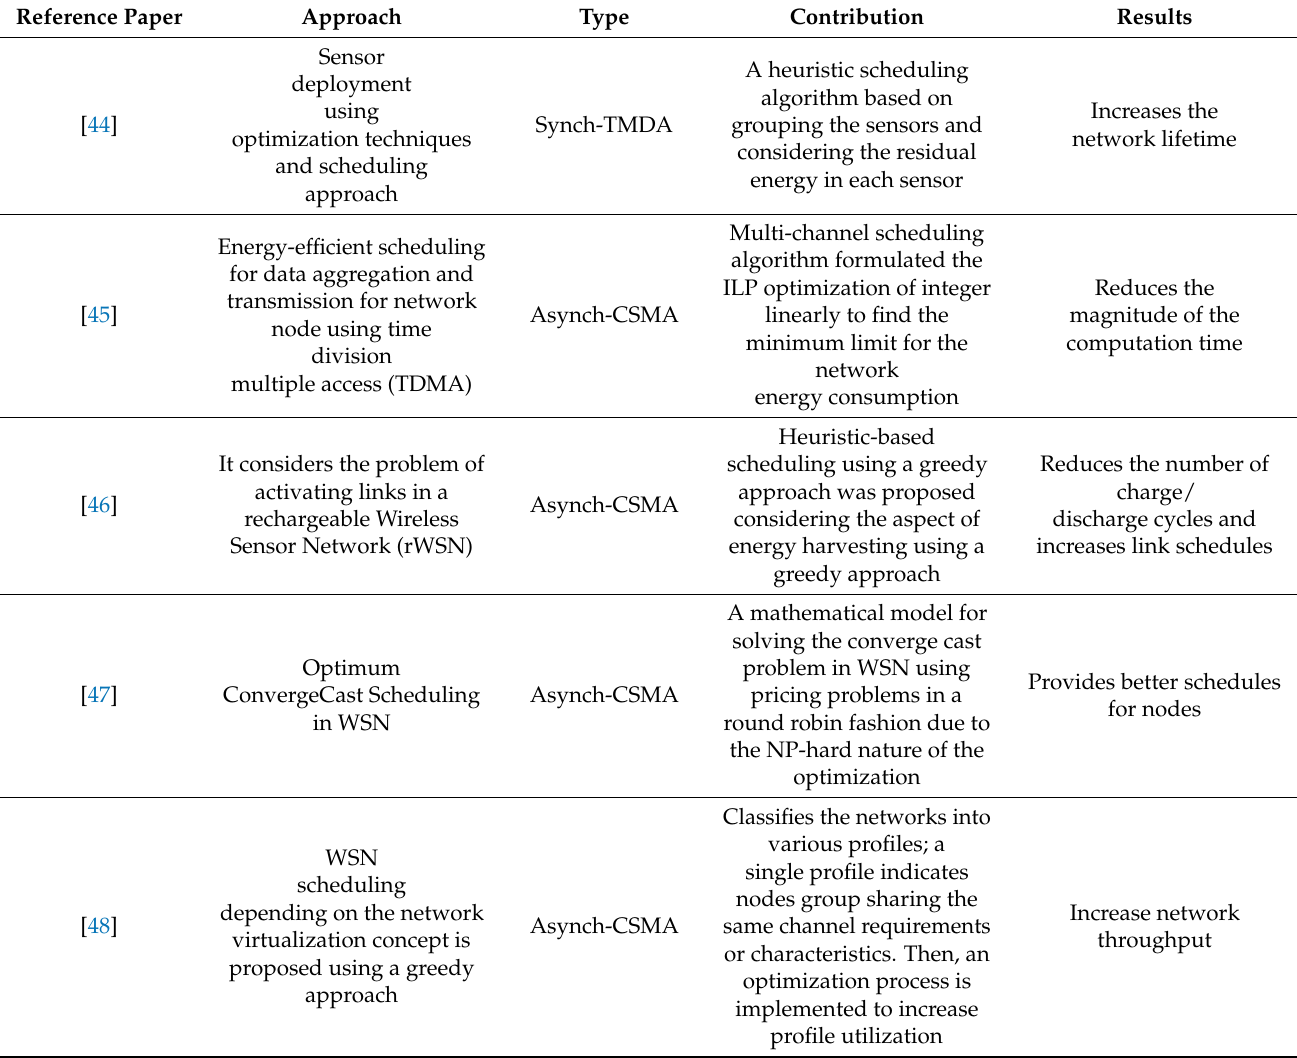
Table 3. Heuristics-based MAC